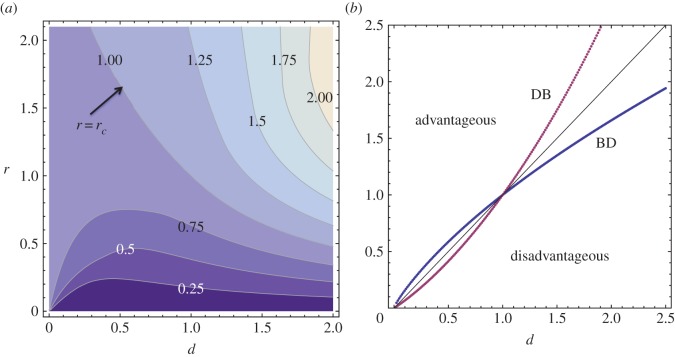
One-dimensional process: properties of the fixation probabilities. (a) The ratio πBD−1D/πDB−1D is plotted as a function of variables d and r. The contours correspond to equal values of this quantity, and lighter colours mark higher values. Above the line r=rc, the probability of fixation is larger for the BD process. The parameter N=100 is used. (b) Neutrality of mutants. Plotted are the lines in the (d,r) space along which the probability of mutant fixation is equal to 1/N (the line πBD−1D=1/N is blue, and the line πDB−1D=1/N is red; the line r/d=1 is black). Parameter N=5 was used.